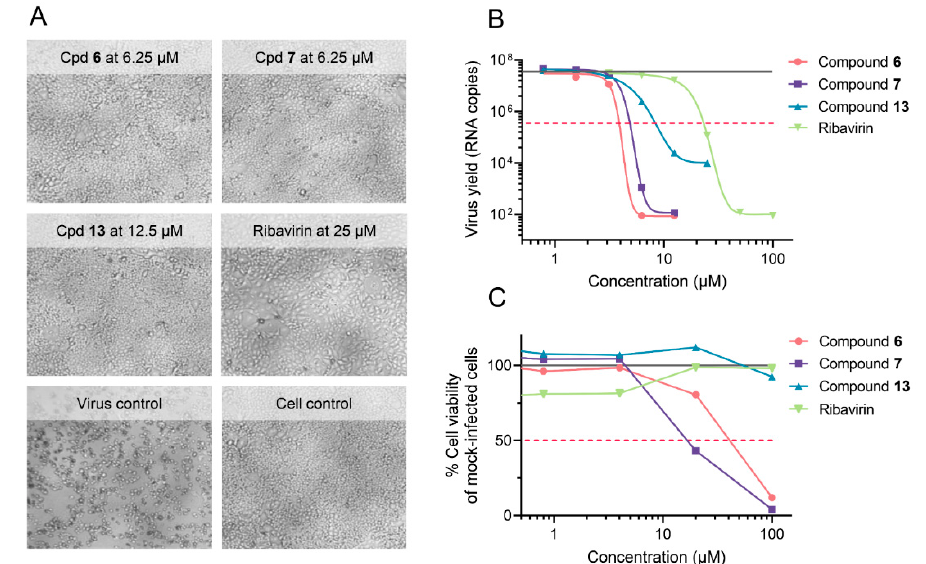
Figure 1. Anti-influenza virus activity of compounds 6 , 7 , and 13 , in MDCK cells at day 3 p.i. with A/PR/8/34 virus. ( A ) Representative images showing complete inhibition of viral cytopathic effect (CPE) at compound concentrations devoid of any cytotoxicity. ( B ) Reduction in virus yield, as determined by RT-qPCR for viral RNA in the supernatant (lower limit of detection: 10 1.6 copies). Curve fitting by GraphPad Prism, on two data points from one experiment performed in duplicate. Full grey line: Virus yield for untreated virus control; red dashed line: 100-fold reduction in virus yield. ( C ) Compound cytotoxicity in mock-infected cells, determined by MTS cell viability assay (mean data from three experiments). Full grey line: 100% viability in the cell control receiving no compound; red dashed line: 50% cell viability.